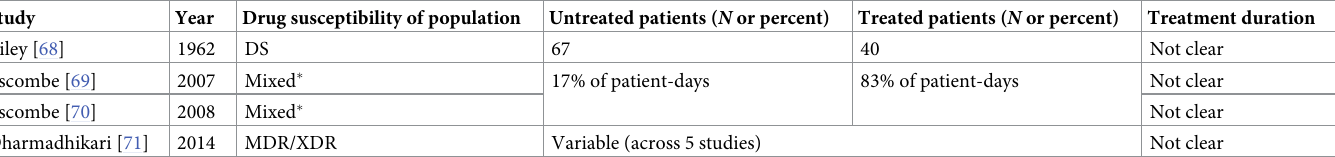
Table 7. Studies evaluated for data on infectiousness from TB patients to animals during TB treatment.